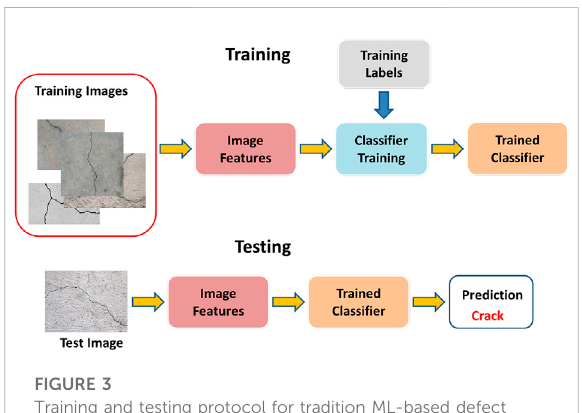
FIGURE 3 Training and testing protocol for tradition ML-based defect classi fi